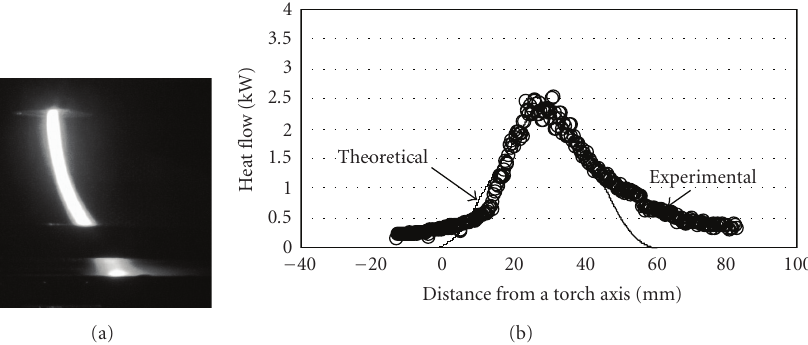
Figure 8: Comparison of the experimental variation of heat flow from a magnetically driven arc to the calorimeter with the theoretical variation of heat flow at Y =